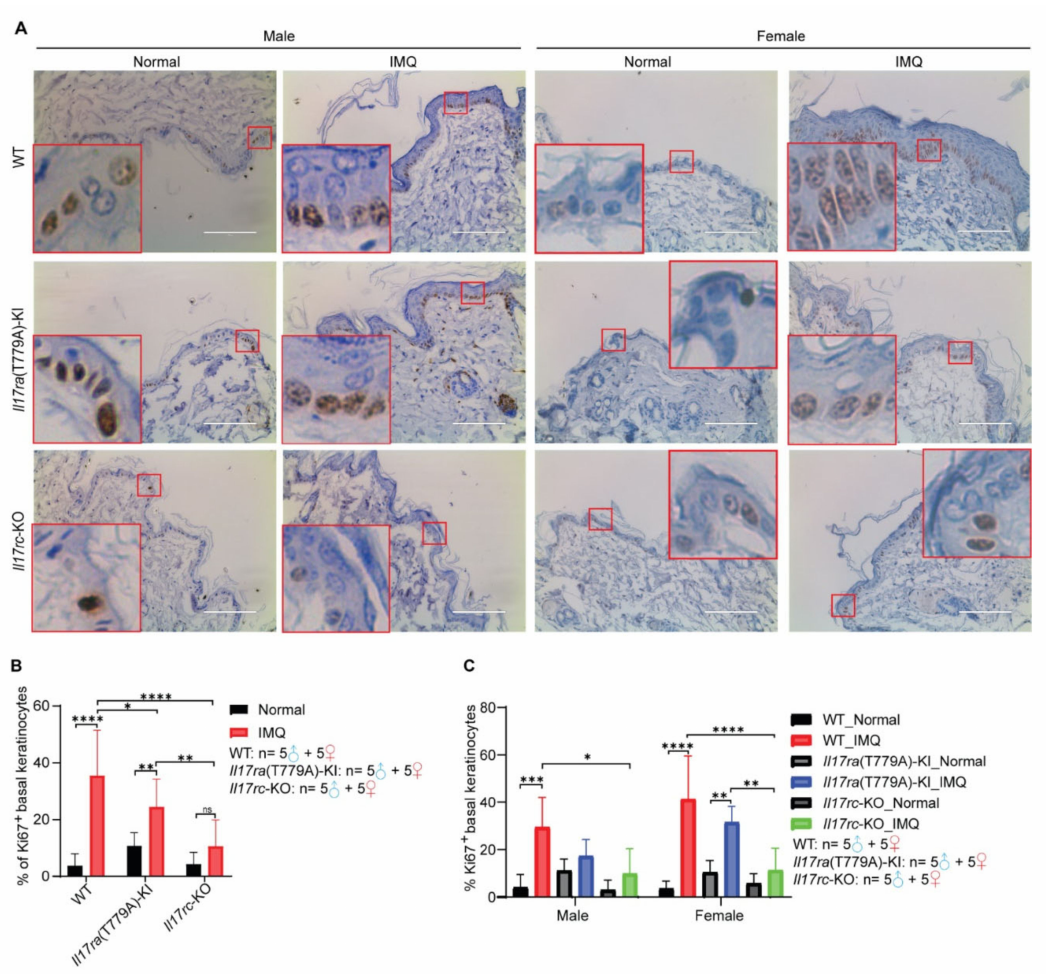
Figure 4. Knockout of Il17rc inhibits keratinocyte proliferation induced by imiquimod. ( A ) Repre- sentative of immunohistochemical staining of Ki67 in the epidermis of skin lesions. Skin samples of 5 male mice and 5 female mice of each subgroup were used for immunohistochemical staining. Representative areas showing basal keratinocytes were zoomed in. Scale bar represents 100 µ m. ( B , C ) Percentage of Ki67 + basal keratinocytes were counted, and statistical significance was assessed with a two-tailed Student’s t test. Scale bar represents 100 µ m. Error bar represents mean ± SD; ns—no significance; *— p < 0.05; **— p < 0.01; ***— p < 0.001; ****— p < 0.0001. The numbers of male and female mice in each group are indicated in the